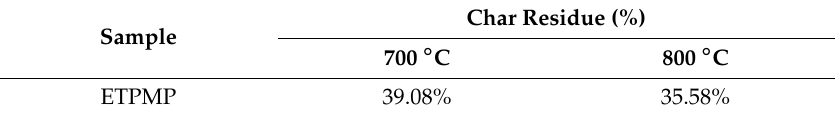
Table 2. TGA results of ETPMP.